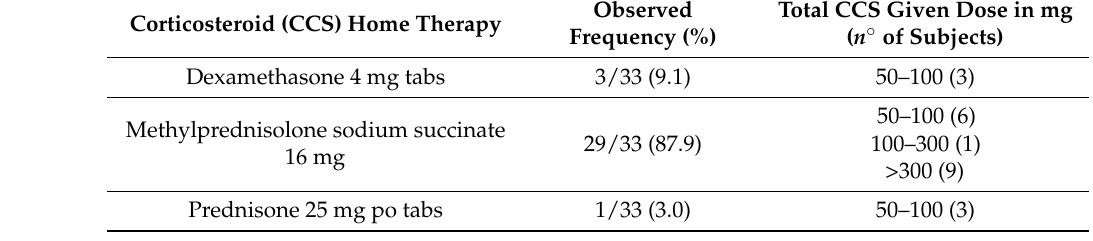
Table 2. List of oral corticosteroids.